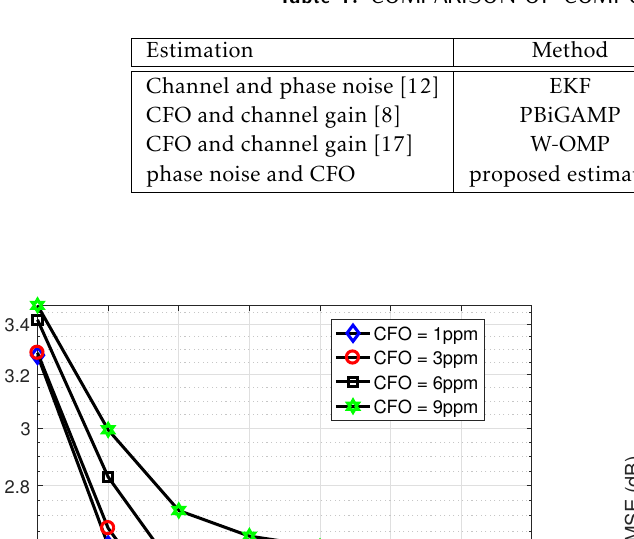
Table 1. COMPARISON OF COMPUTATIONAL COMPLEXITY